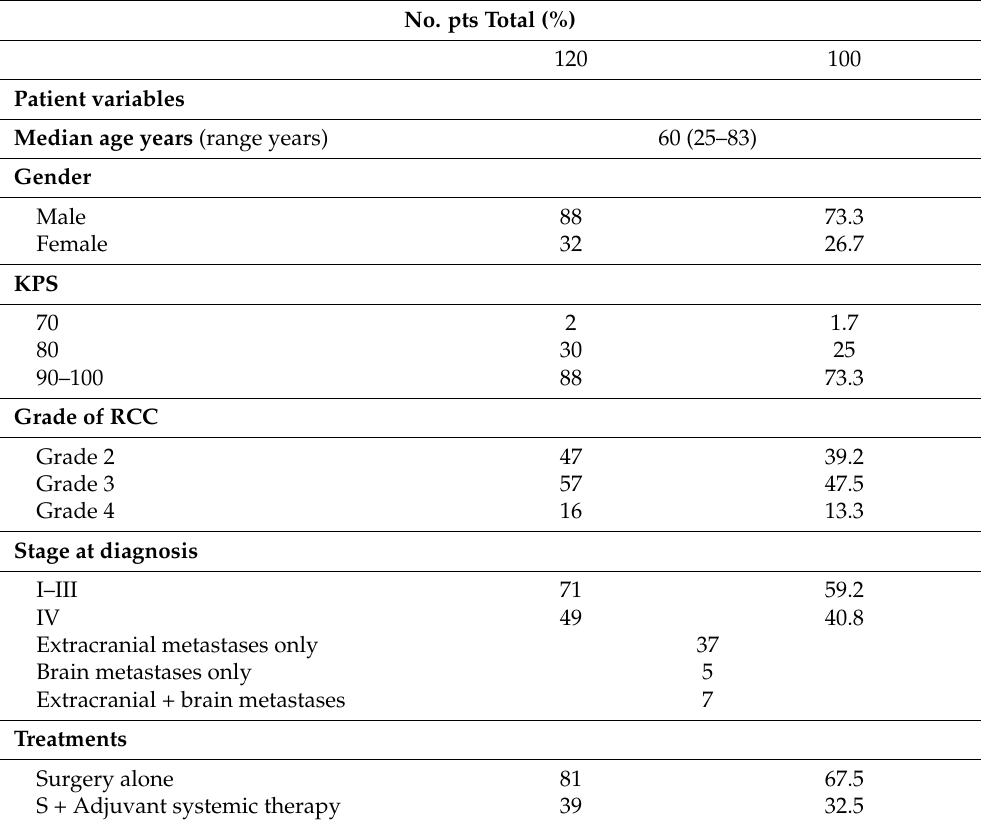
Table 1. Baseline patient, tumor, and treatment characteristics.